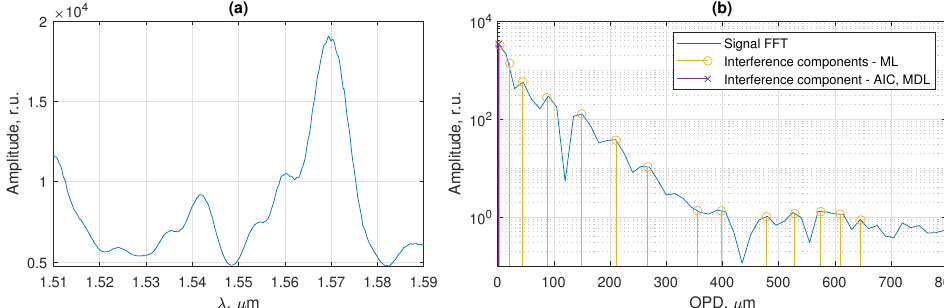
Figure 8. Example of a spectral-interference signal measured in the intermode interferometer with 5 cm sensing MMF section ( a ) and its Fourier transform with interference components identified using the proposed ML approach and both AIC and MDL criteria ( b